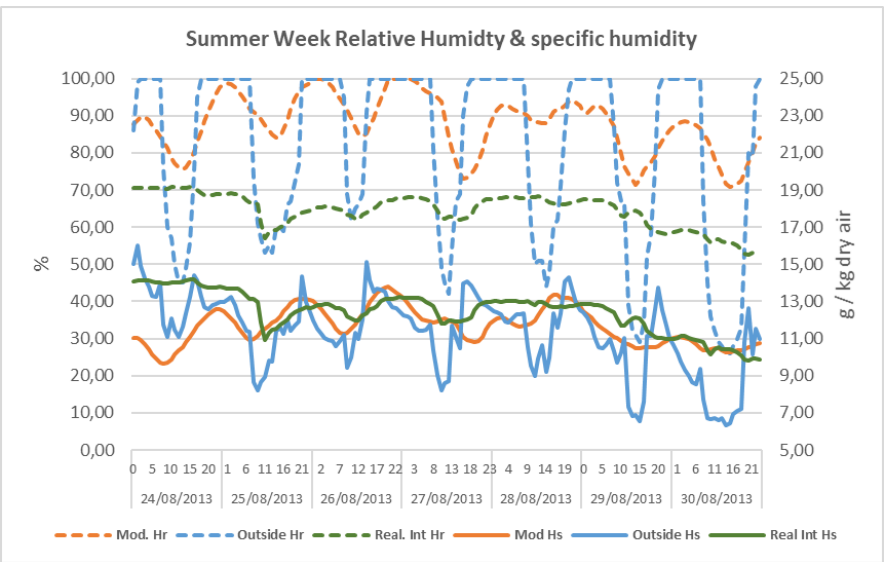
Figure 26. Hourly outdoor temperatures, real and modeled indoor temperatures, and outdoor and real indoor relative humidity (summer).